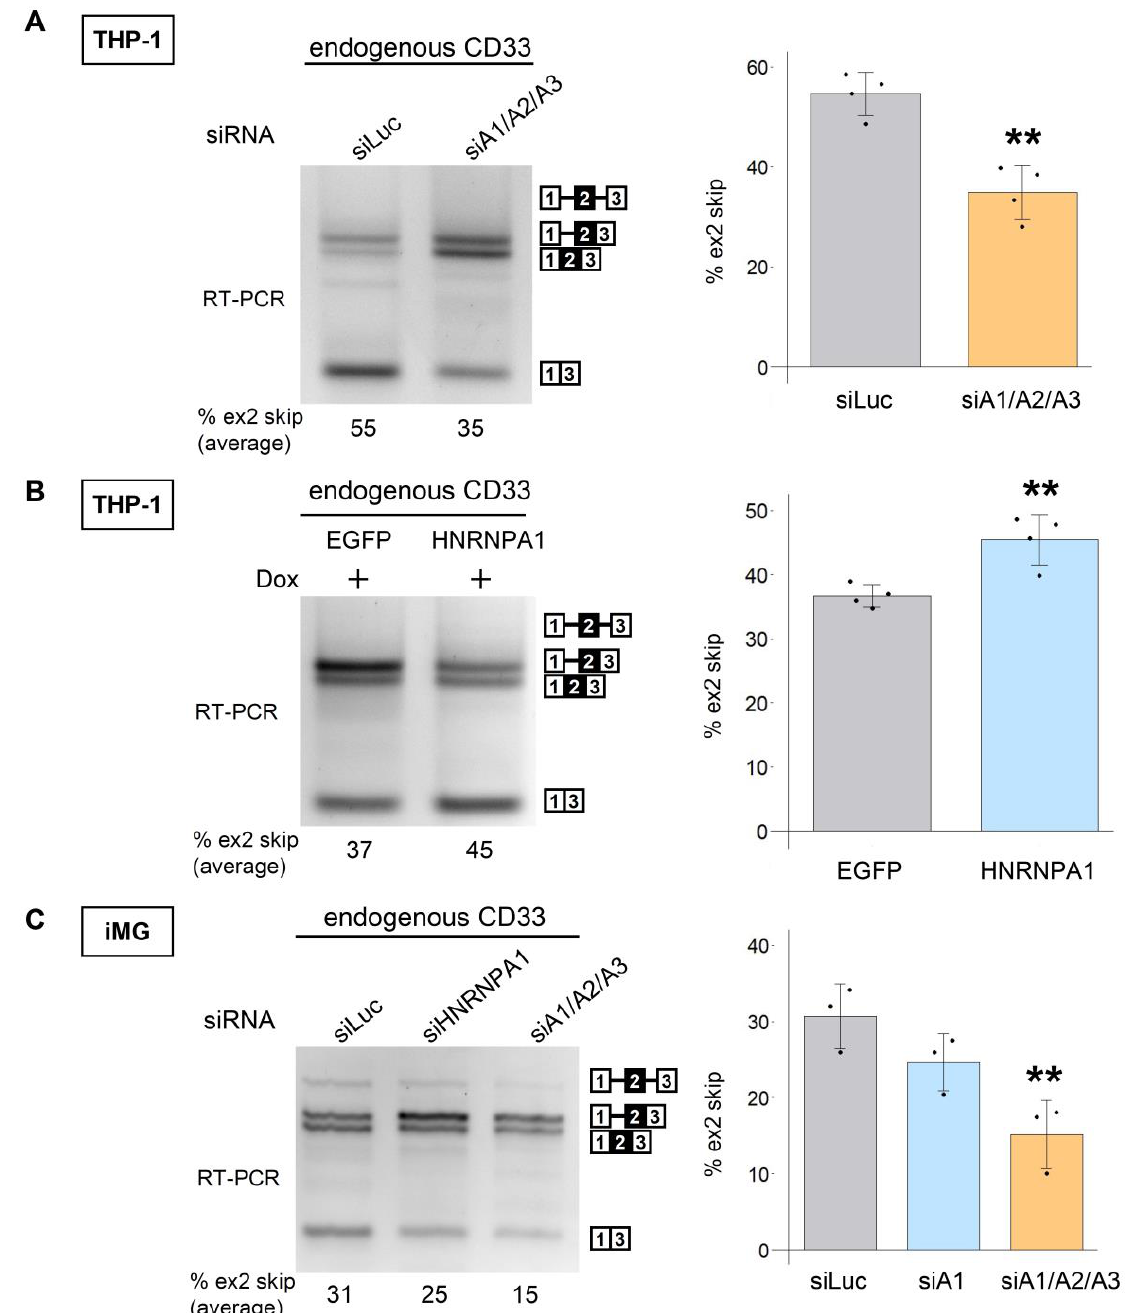
Figure 3. Endogenous CD33 splicing is regulated by HNRNPA proteins. ( A ) THP-1 cells were treated with siRNA against luciferase or HNRNPA paralogs (siA1/A2/A3) and were assessed via splicing analysis ( left panel ). Quantified results are shown in the bar chart ( n = 4). ** p = 0.0012 (two-tailed unpaired t -test). ( B ) Expression of EGFP or EGFP-HNRNPA1 in THP-1 cells was induced with 1 μ g/mL doxycycline, and mRNA was amplified using RT-PCR to detect the splicing pattern of endogenous CD33 ( left ). The bar chart shows the proportion of exon 2 skipping. Error bars represent SD ( n = 4). Welch’s t -test was used for statistical evaluation (** p = 0.0066). ( C ) Microglia-like cells converted from human-induced pluripotent stem cell-derived microglial cells (iMG cells, Cellartis Microglia) were treated with siRNA, and mRNA was amplified using RT-PCR ( left panel ), which was quantitatively analyzed ( right panel ). Error bars represent the SD ( n = 3). Tukey’s test was used for statistical evaluation (** p = 0.0091).